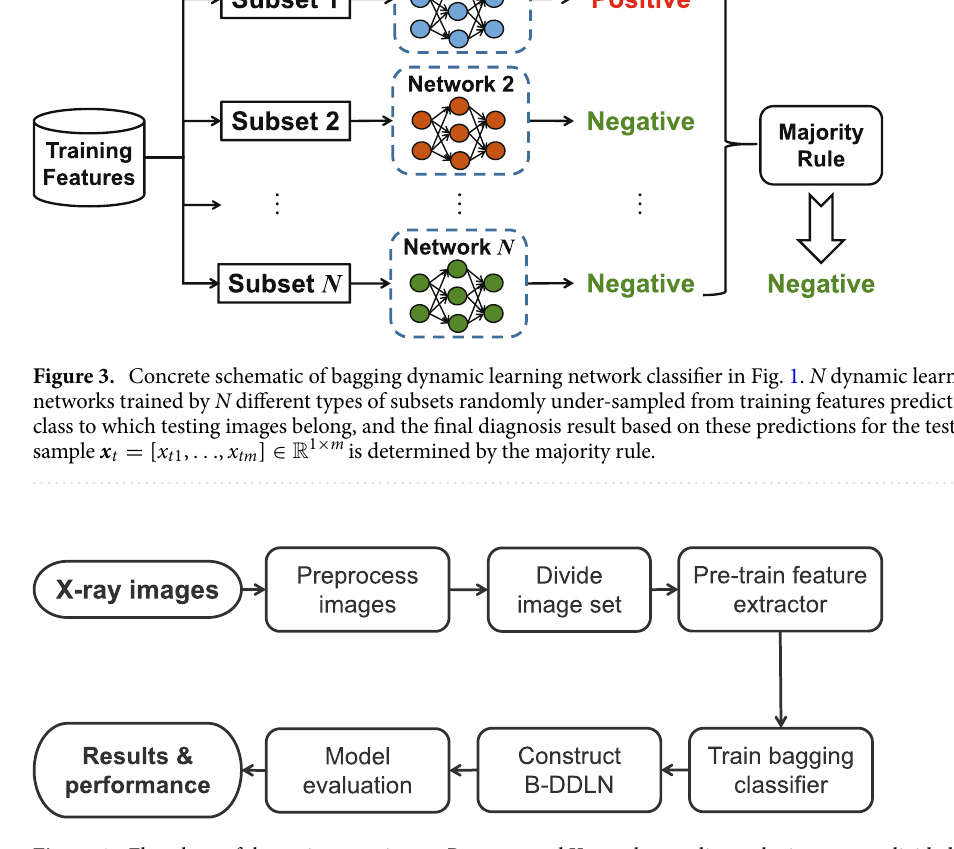
Figure 4. Flowchart of the entire experiment. Preprocessed X-ray chest radiography images are divided into training and testing sets. The training images are used to pre-train convolution blocks as a feature extractor, and a bagging dynamic learning network classifier is subsequently trained to construct B-DDLN diagnosis model. Testing images are used to evaluate the proposed B-DDLN to obtain diagnosis results and corresponding